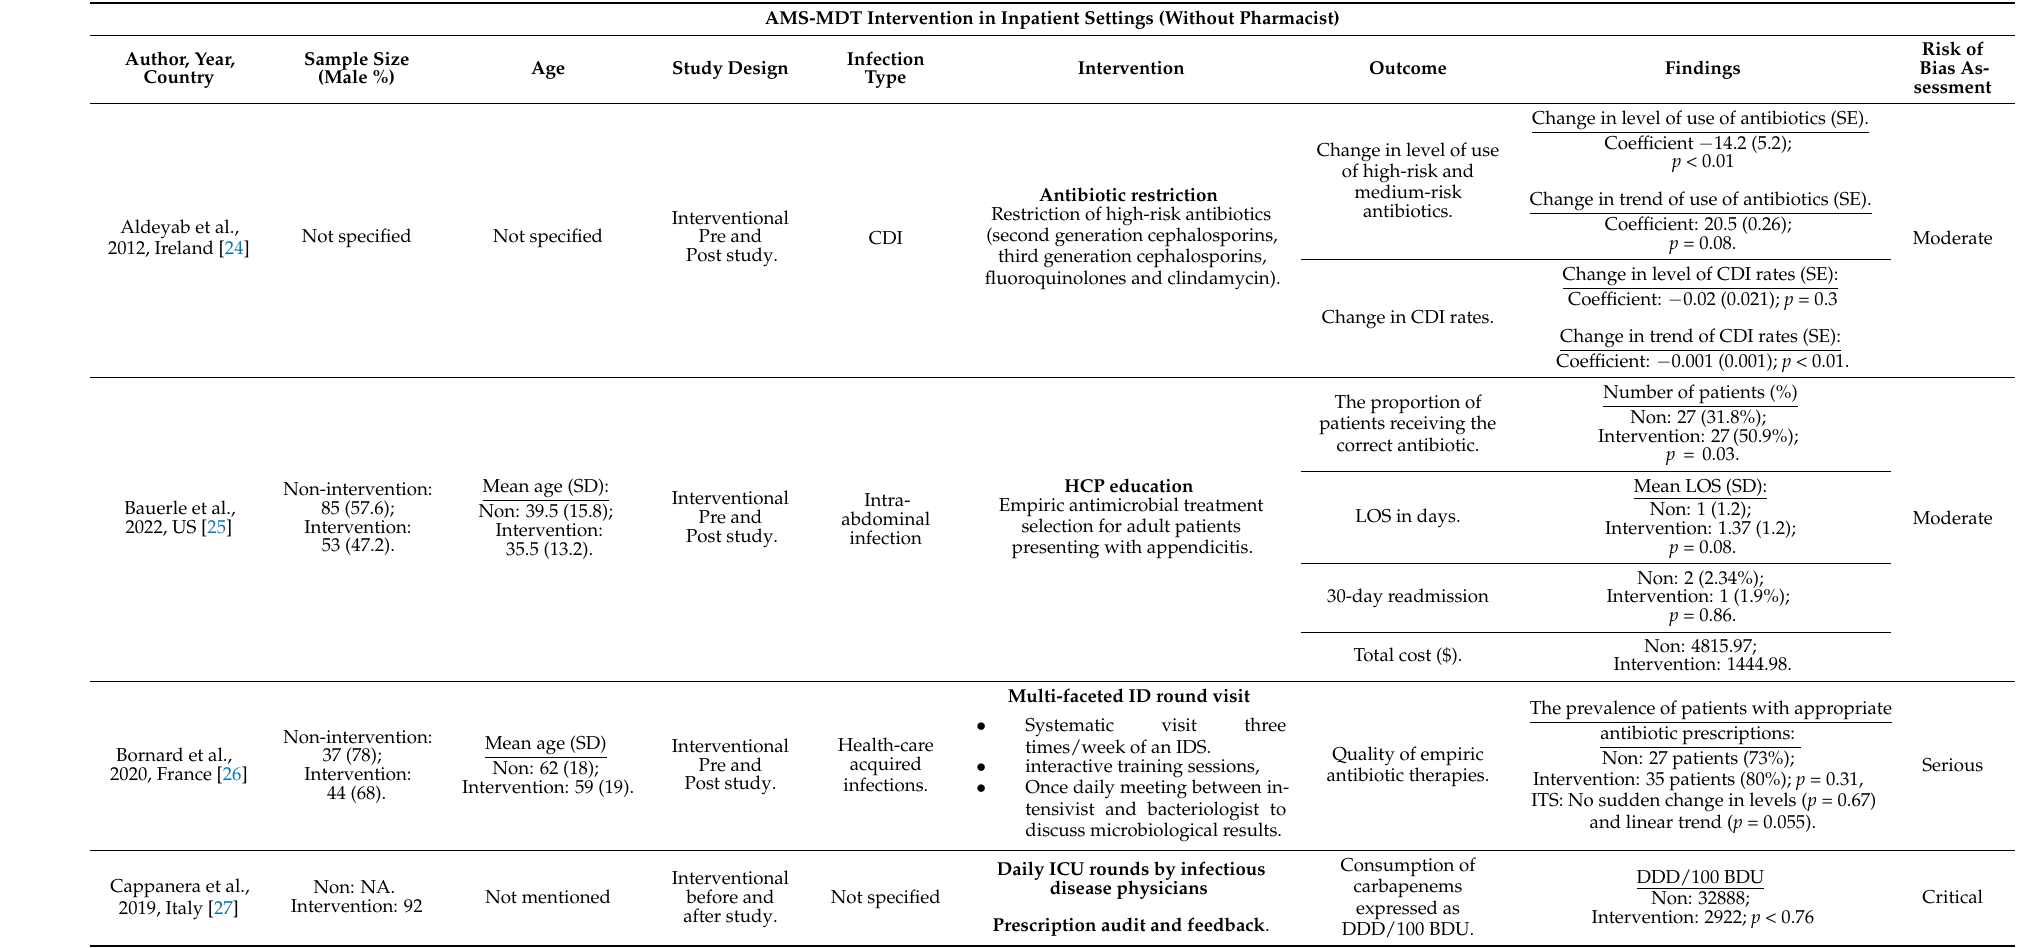
Table 1. Data extraction